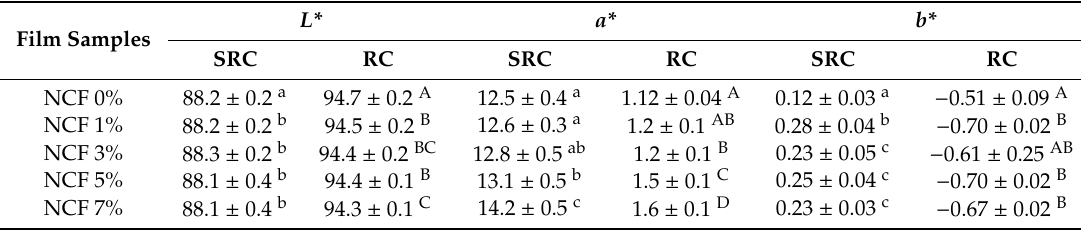
Table 2. Color properties of the SRC and RC